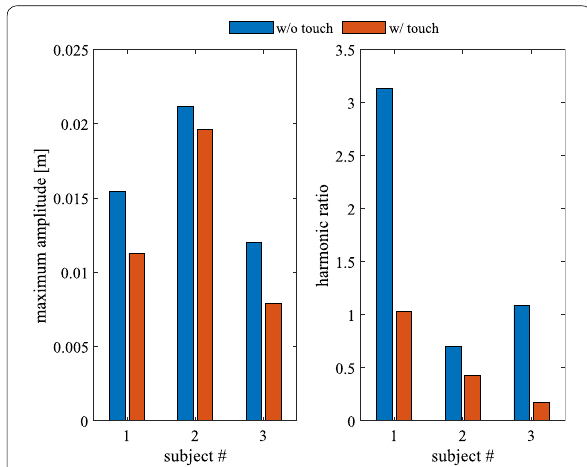
Fig. 15 Maximum amplitude and harmonic ratios of the postural angle projected on the sagittal plane of each subject. The left figure shows the maximum amplitudes of the postural angle projected on the sagittal plane at the frequencies of the trials, and the right figure shows the harmonic ratios of them. The maximum amplitudes of all subjects slightly decreased. On the other hand, the harmonic ratios of